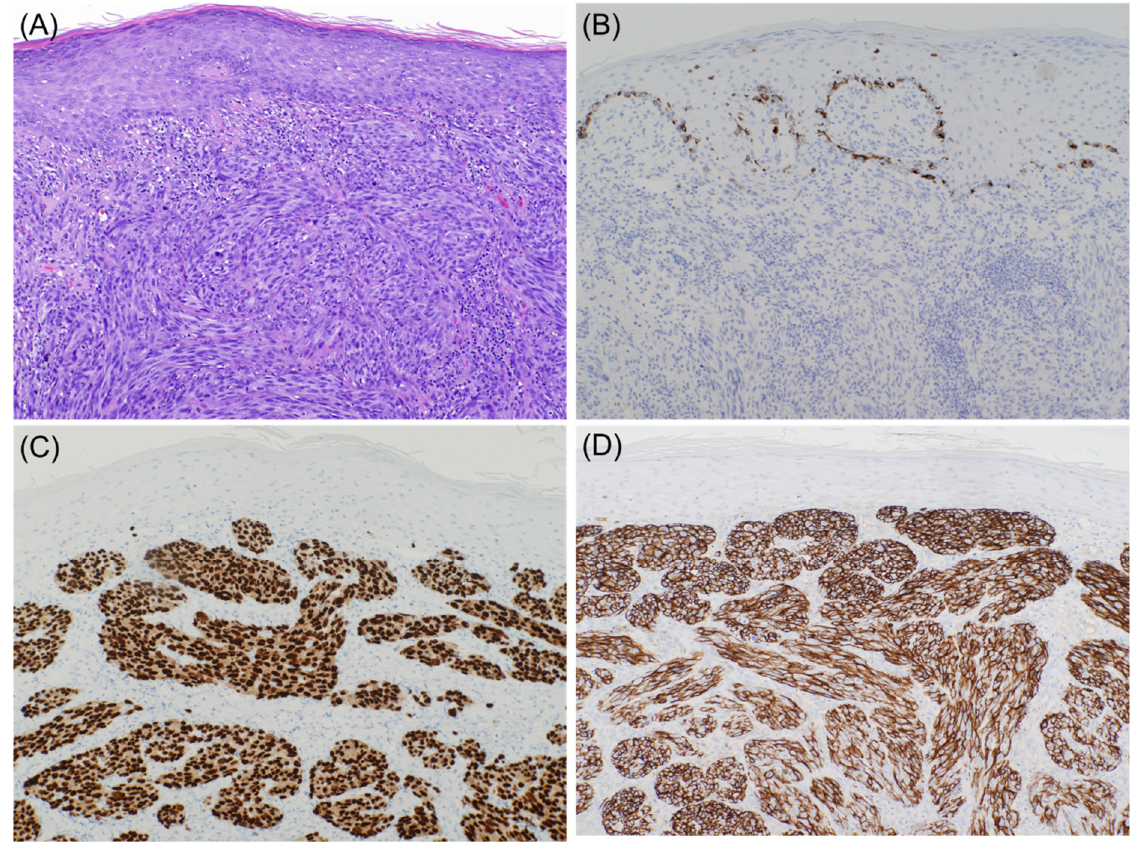
Figure 1. Spindle cell melanoma (( A ), hematoxylin and eosin (H & E) stain × 10. Lesional cells are negative for Mart-1 (( B ), immunohistochemical stain × 10) and positive for SOX10 (( C ), immunohistochemical stain × 10) and NGFR (( D ), immunohistochemical stain × 10).